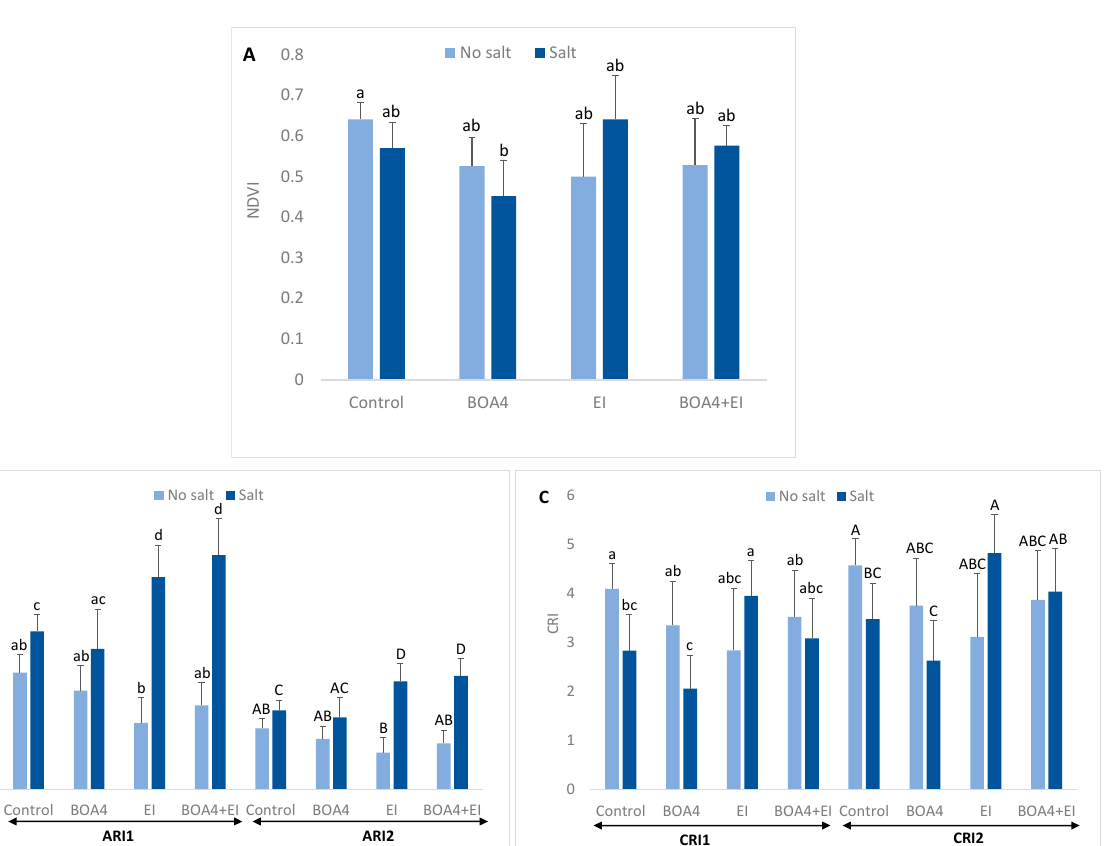
Figure 4. Reflectance indices determined for 50-day-old plants subjected to the different treatments. NDVI (panel ( A )); ARI indices (panel ( B )); CRI indices (panel ( C )). No-salt and salt stress conditions are represented by light-colored and dark-colored columns, respectively. BOA4: Achromobacter xylosoxidans strain BOA4; EI: Enteromorpha intestinalis extract; BOA4 + EI: Achromobacter xylosoxidans strain BOA4 plus Enteromorpha intestinalis extract. Bars represent standard deviation. Different lower-case or upper-case letters above the bars indicate means that differ significantly ( p < 0.02, p < 0.001 and p = 0.01, for panels ( A ), ( B ) and ( C ), respectively).